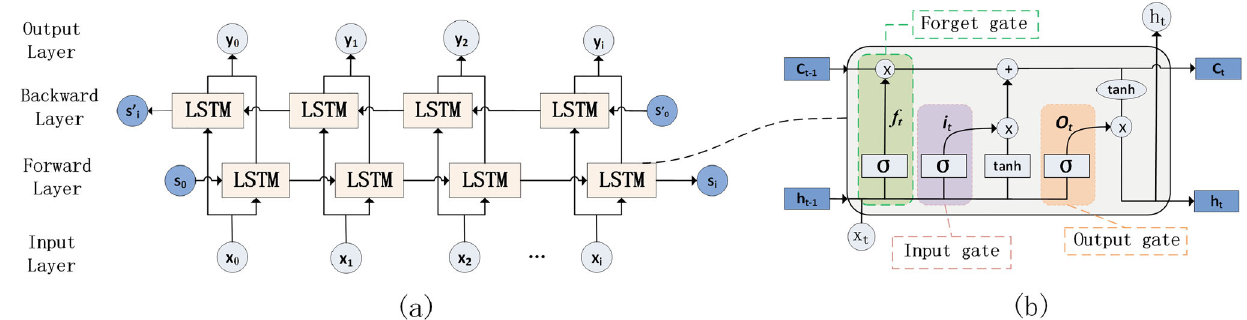
Fig. 3 The working mechanism of bidirectional long short-term memory networks